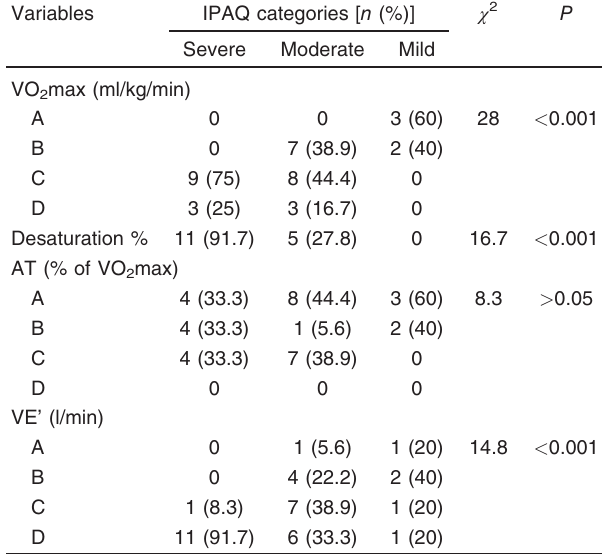
Table 4 Relation between cardiopulmonary exercise testing and International Physical Activity Questionnaire Variables